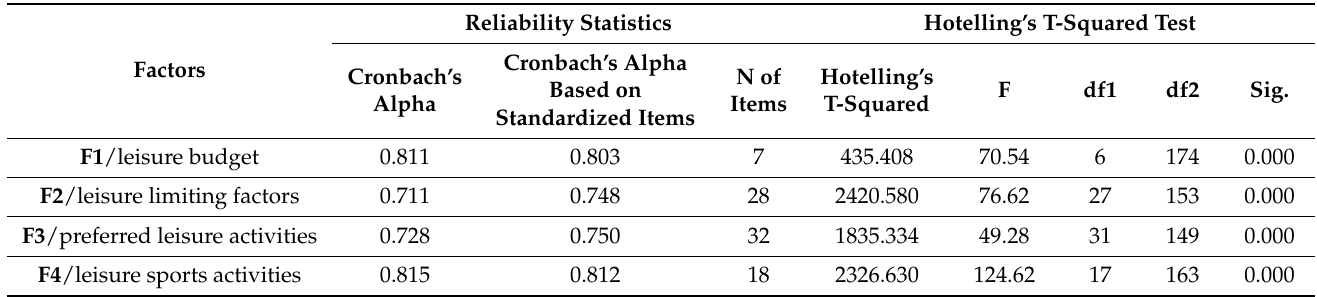
Table 1. The values of the reliability value coefficient (Cronbach’s Alpha) and the test of equality of the averages for the answers to the items of the 4 factors of the questionnaire/N = 180.